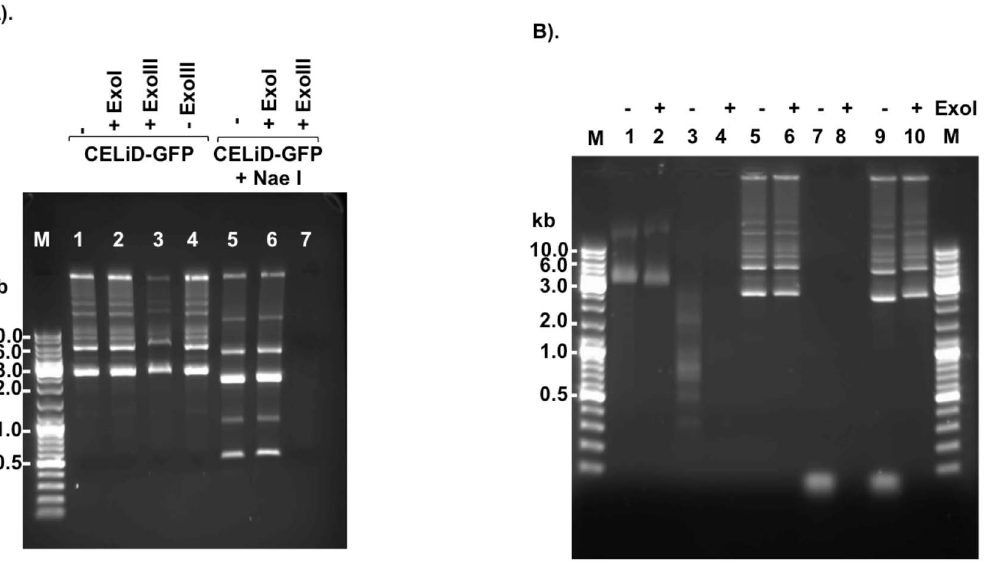
Figure 5. CELiD-GFP DNA sensitivity to exonuclease I and exonuclease III. E. coli exonuclease III (ExoIII) removes nucleotides processively (3 9 – . 5 9 ) from DNA initiating at a 3 9 -OH of either blunt-ended or 5 9 protruding duplex DNA. E. coli exonuclease I (ExoI) degrades single-stranded DNA processively in a 3 9 to 5 9 direction. (A) Total CELiD DNA (1 m g) was incubated with either ExoI (20 units) or ExoIII (100 units), either without prior restriction enzyme (RE) digestion (left) or following RE digestion (right). Lane M: DNA size ladder. Lane 1: untreated CELiD DNA. Lane 2: CELiD DNA treated with ExoI. Lane 3: CELiD DNA treated with ExoIII. Lane 4: untreated CELiD DNA. Samples in lanes 5, 6, 7 were digested with NaeI prior to exonuclease treatment. Lane 5: no exonuclease control. Lane 6: ExoI treatment. Lane7: ExoIII treatment. (B) Additional substrates as controls for ExoI activity. The w X174 virus genome is a 5386 nt, single-stranded, closed circular DNA molecule. ExoI treatment is indicated above each lane by a ‘‘ + ’’ or ‘‘–’’ sign. Lanes 1 and 2: w X174 DNA. Lanes 3 and 4: w X174 DNA digested with HaeIII. Lanes 5 and 6: CELiD DNA. Lanes 7 and 8: single-stranded synthetic oligonucleotide (25mer). Lanes 9 and 10: Mixed CELiD DNA and 25mer.